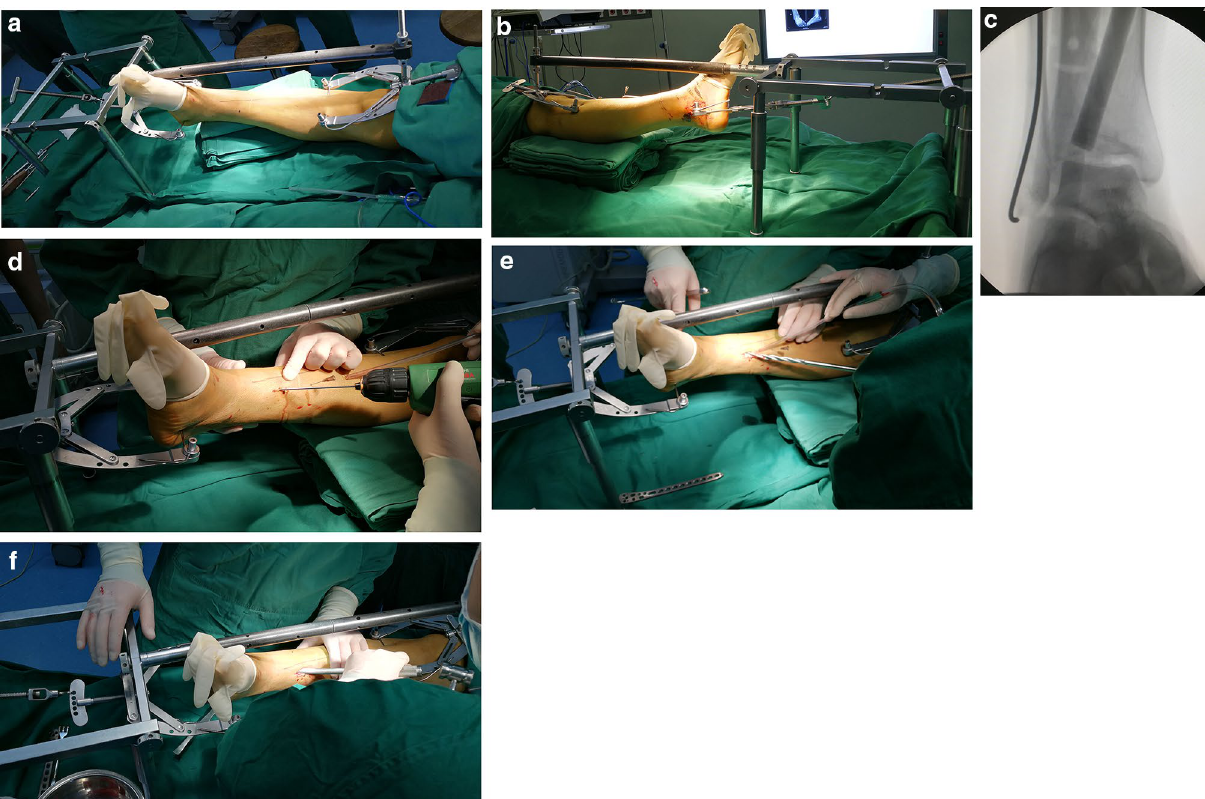
Figure 1. The process of fractures reduction with DRTR. ( a ) and ( b ) The anterior–posterior view and lateral view of DRTR in the surgery. ( c ) The reduction of collapsed fractures under fluoroscopy. ( d ) A Kirschner